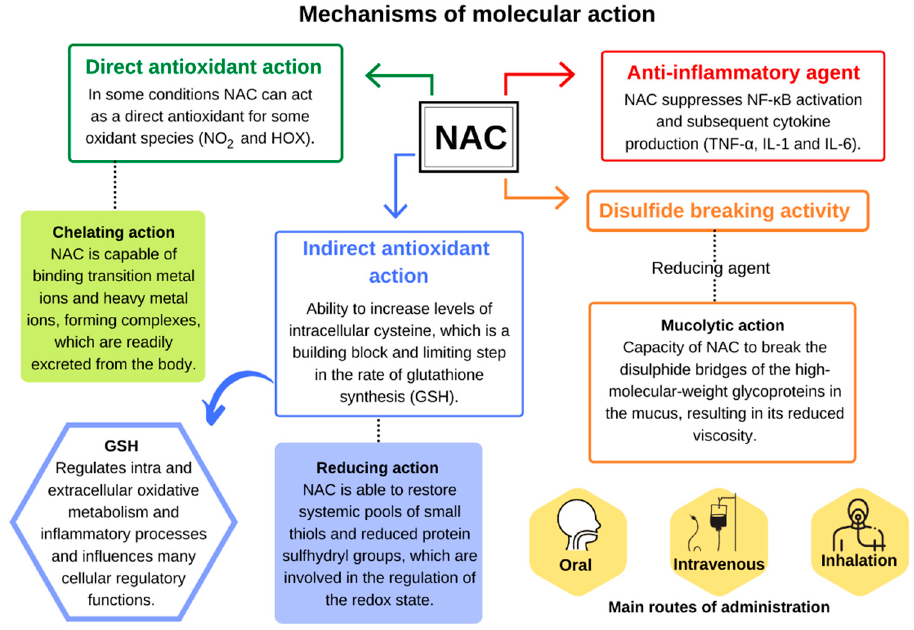
Table 1. Rate constants of N -acetylcysteine reactions with various compounds under different ex- perimental conditions. Reactive Species